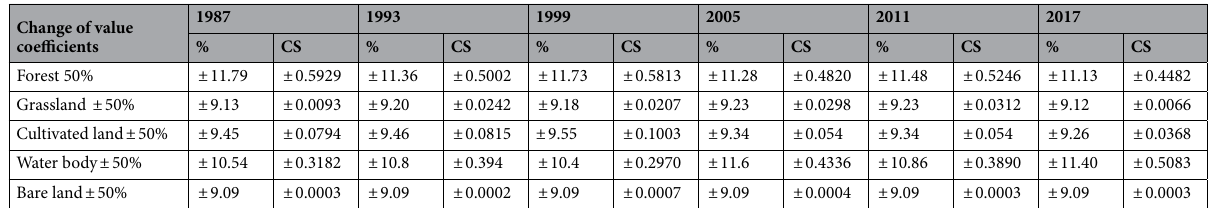
Table 6. Sensitivity index of ESV